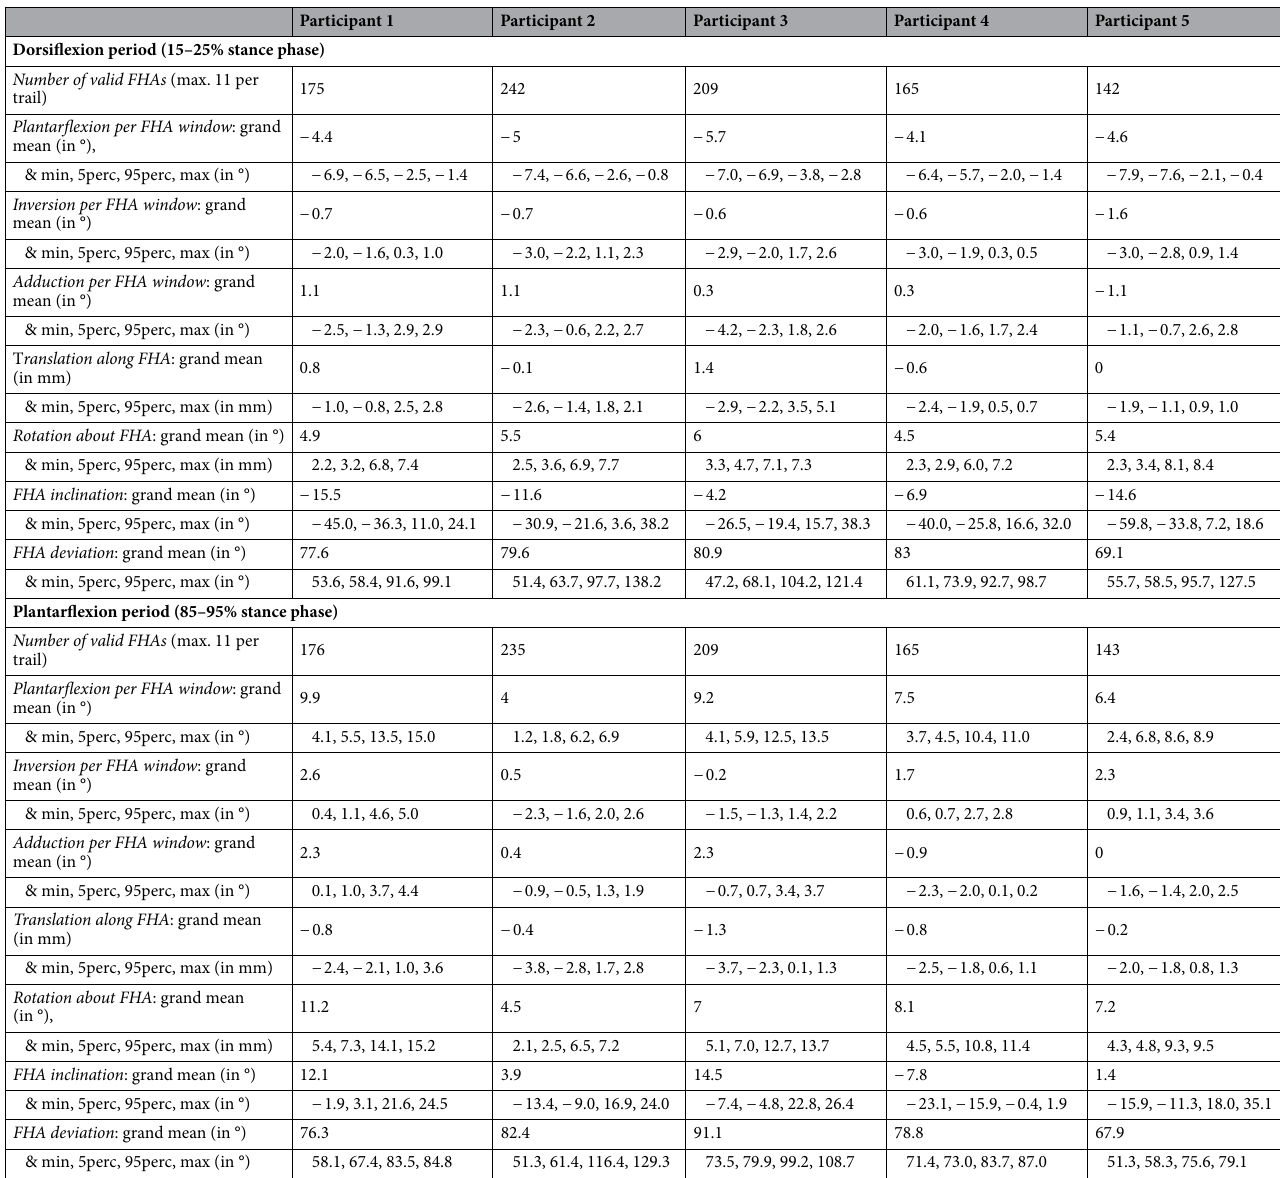
Table 2. Characteristics of an ankle joint axis representative for the dorsiflexion and plantarflexion period in